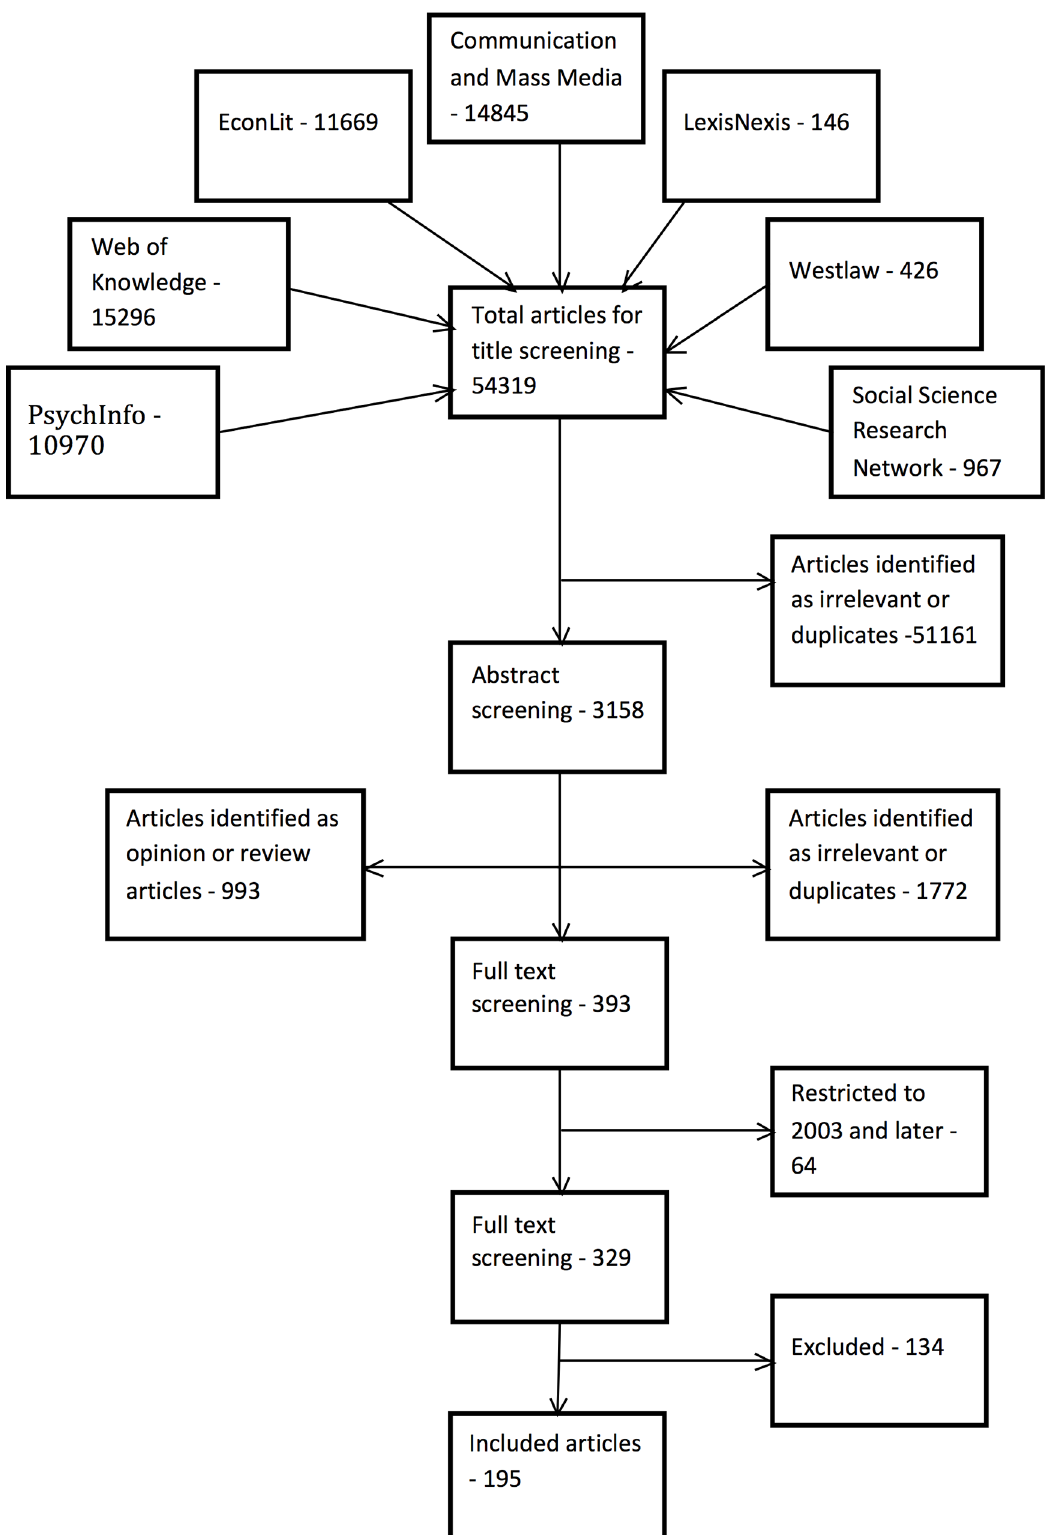
Fig 1. Flow diagram of academic articles included in the review (in addition to 14 grey literature articles).